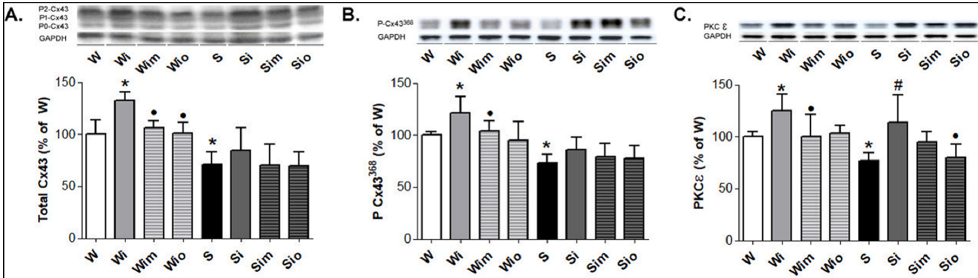
Figure 6. Western blot demonstration of Cx43 protein levels ( A ), its functional phosphorylated forms ( B ) and PKC ε protein levels ( C ) in experimental rats. Note reduced levels of Cx43 in S compared to W rats and increase of Cx43 ( p < 0.05 in W) along with PKC ε in ISO-stressed rats of both strains. In contrast, treatment by melatonin and omega-3 prevented an increase of these parameters in W rat and to a lesser extent in S hearts. W-Wistar rats; Wi-isoproterenol injured W; Wim-melatonin treated Wi; Wio-omacor treated Wi; S-spontaneously hypertensive rats; Si-isoproterenol injured S; Sim-melatonin treated Si; Sio-omacor treated Si. Values are the mean ± SD of 10 rats in each group. * p < 0.05 compared with